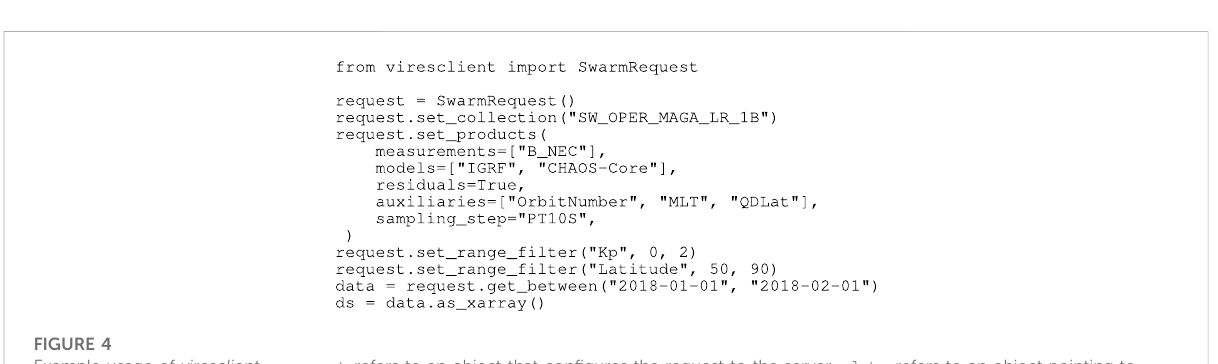
FIGURE 4 Example usage of viresclient .request refers to an object that con fi gures the request to the server .data refers to an object pointing to temporary data that has been created on-disk, delivered from the server .ds is an in-memory representation of the data loaded using the Xarray